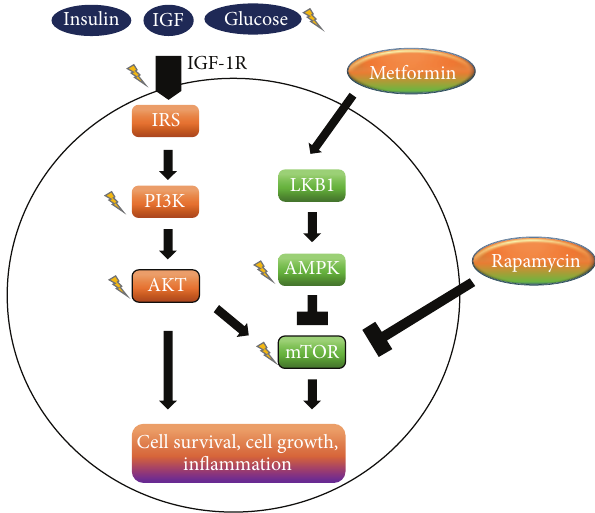
Figure 2: Metabolic manipulation of the AMPK overlaps with activation via exercise. Lightning bolts indicate pathways that affect radiosensitivity. AMPK, AMP-activated protein kinase; IGF- 1, insulin growth factor-1; IRS, insulin receptor substrate; LKB1, liver kinase B1; mTOR, mammalian target of rapamycin; PI3K, phosphatidylinositol 3-kinase. Image is used with permission from Champ et al., 2013